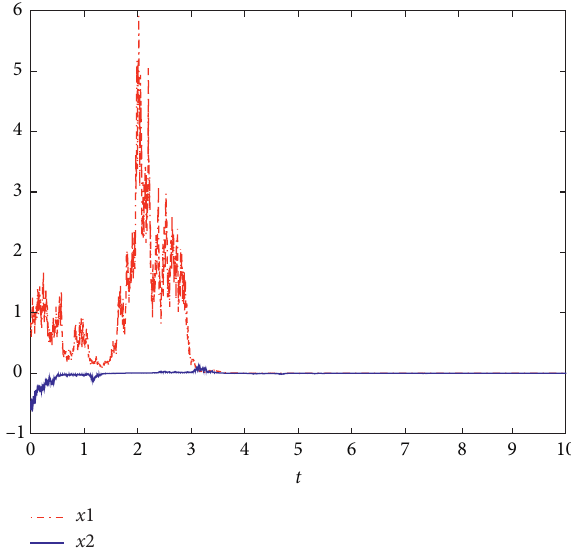
Figure 2: The solution of τ � 1, τ